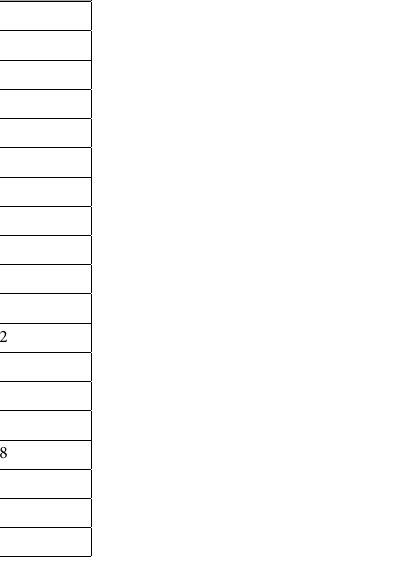
Table 2. Detailed information on the